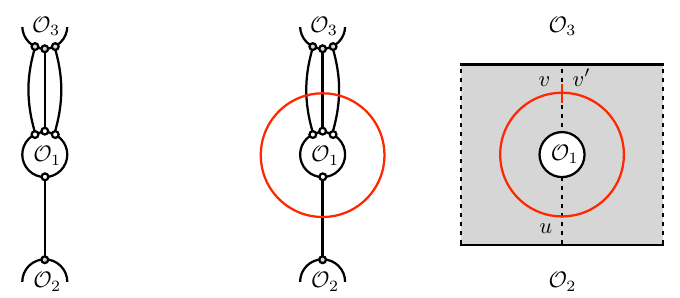
Figure 15 . Tree and one-wheel graph contributing to the half structure constant. The one wheel graph has logarithmic divergence when the wheel shrinks on the central operator. The counterpart of this singularity in the hexagon framework is a double pole in the rapidity di(cid:11)erence u can regularise the divergences by opening up the wheel along a mirror cut and remove the polar part which accompanies the coinciding limit (cid:15) = v 0